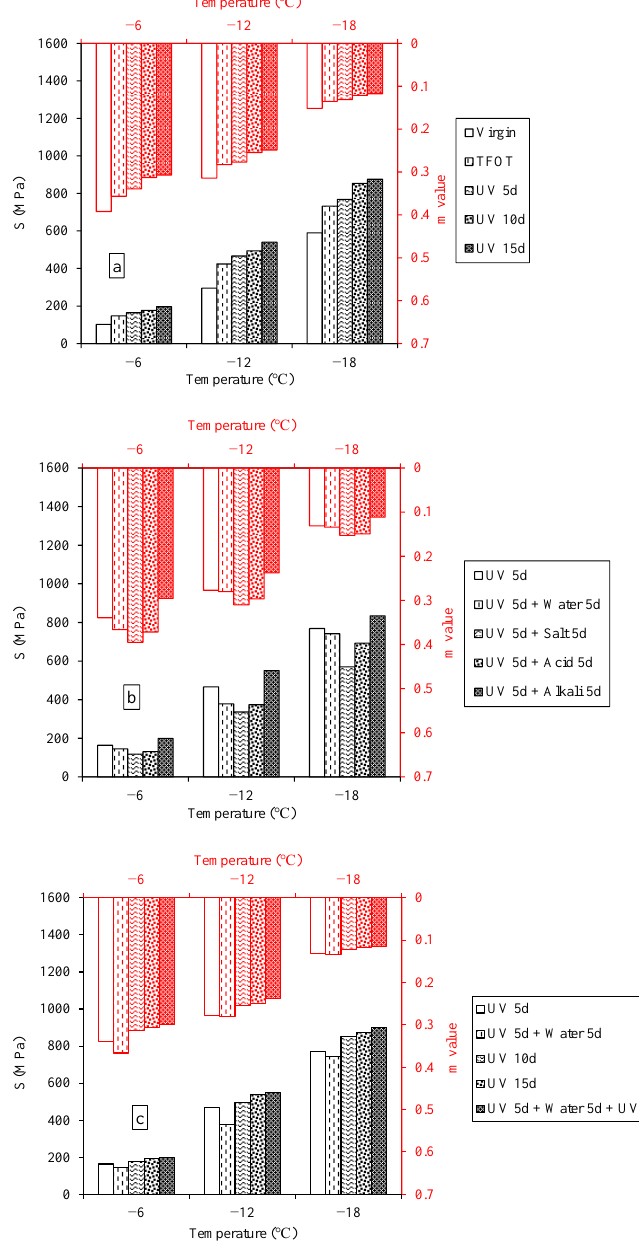
Figure 5. S and m-value of asphalt after the multiple aging of heat, UV and solution. ( a ) multiple aging of heat and UV; ( b ) multiple aging of heat, UV and solution; ( c ) aging cycle of UV and